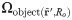
Dependence of F∞ on protrusion size Ro.Simulation data (circles) are fit (solid curves) by fK(Ro) (Eq 15). Data points are the mean of the last 480 points of the simulated F. Error bars are ±1.96 times the standard error of these points. Inset illustrates a doubling of Ro. δr is shown by the green volume. Chain links are shown by white spheres. Protrusions are shown by transparent red spheres. Solid angles subtended by the chain links and protrusion are shown by orange and red cones, respectively. Ωchain is the area on the unit sphere around the center of δr intersecting the orange cones. Ωobject(r˜′,Ro) is the area on the unit sphere intersecting the red cone. Ωchain∩object(r˜′,Ro) is the area on the unit sphere intersecting both orange and read cones.